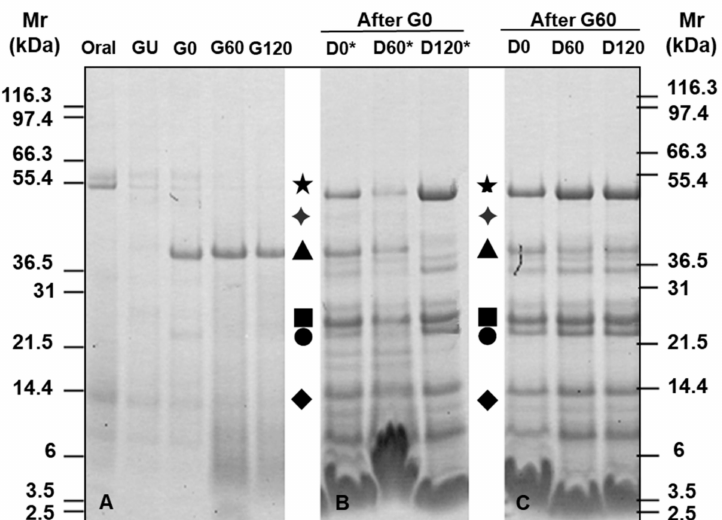
Figure 2. SDS-PAGE profiles of the soluble fraction of in vitro oral, gastric and duodenal